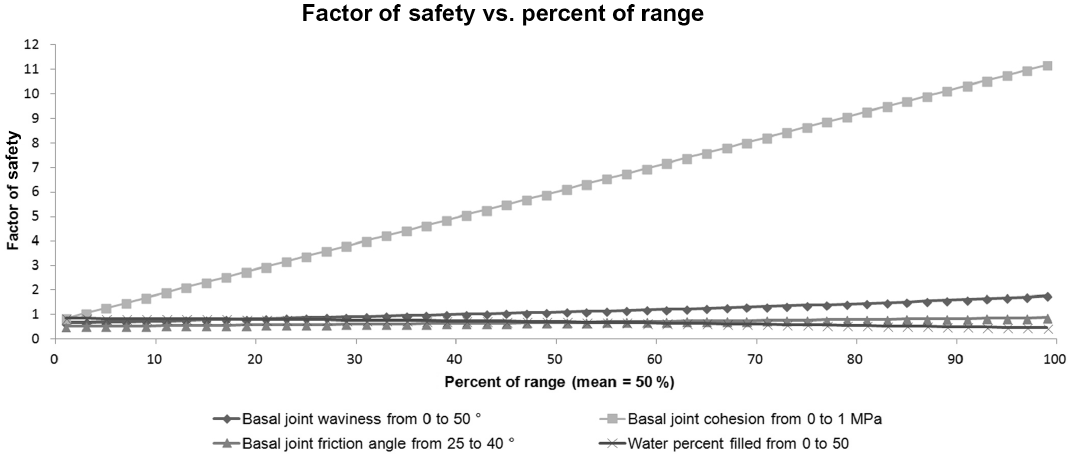
Figure 11. Result of sensitivity analysis relative to the parameters basal joint waviness, friction angle, cohesion and water percent filled. Table 7. Results of the parametric analysis increasing basal plane cohesion values. Rock bridge Intact rock Total cohesion Driving force Resisting force Factor of safety % (m 2 ) (MN) (MN) (MN)